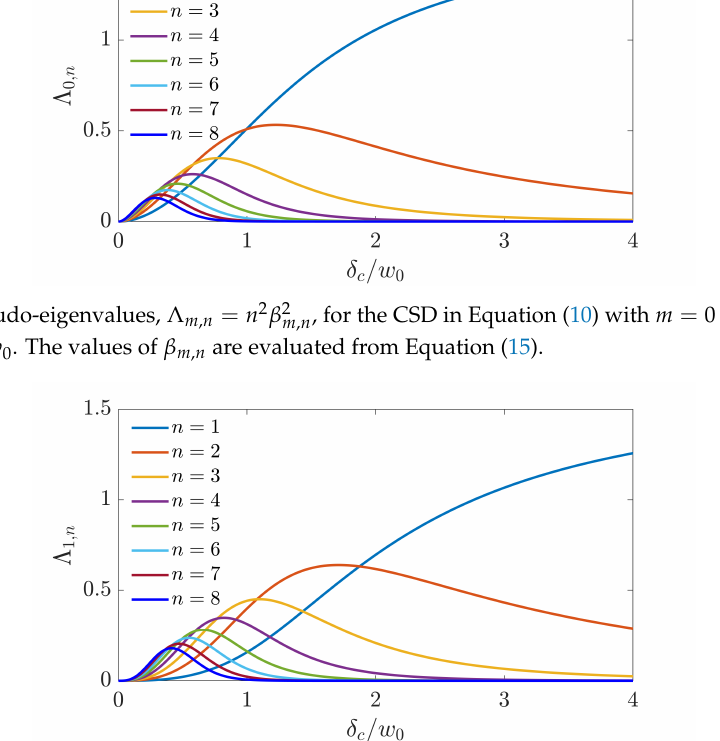
Figure 4. Pseudo-eigenvalues, Λ m , n = n 2 β 2 m , n , for the CSD in Equation (10) with m = 1 as functions of the ratio δ c / w 0 . The values of β m , n are evaluated from Equation